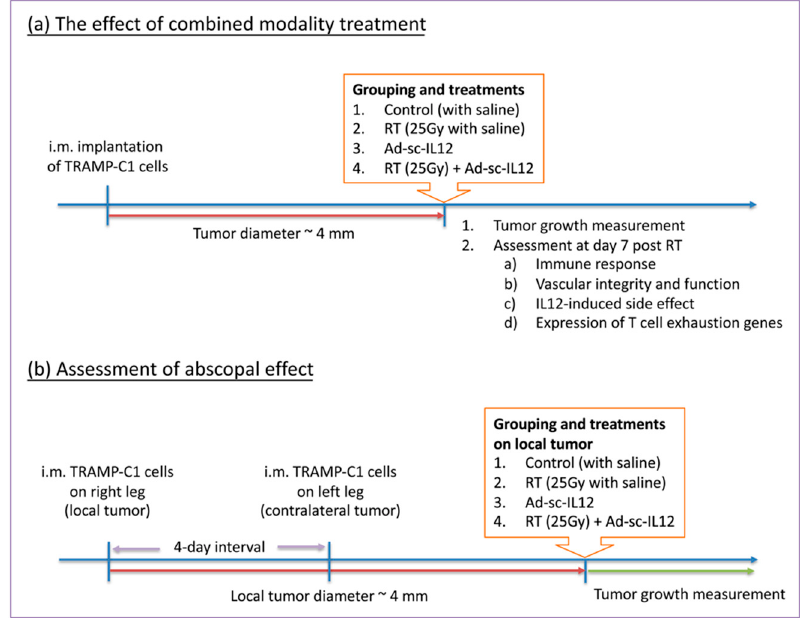
Figure 7. The flow chart for animal experiments in ( a ) the effect of combined modality treatment and ( b ) the assessment of abscopal effect.